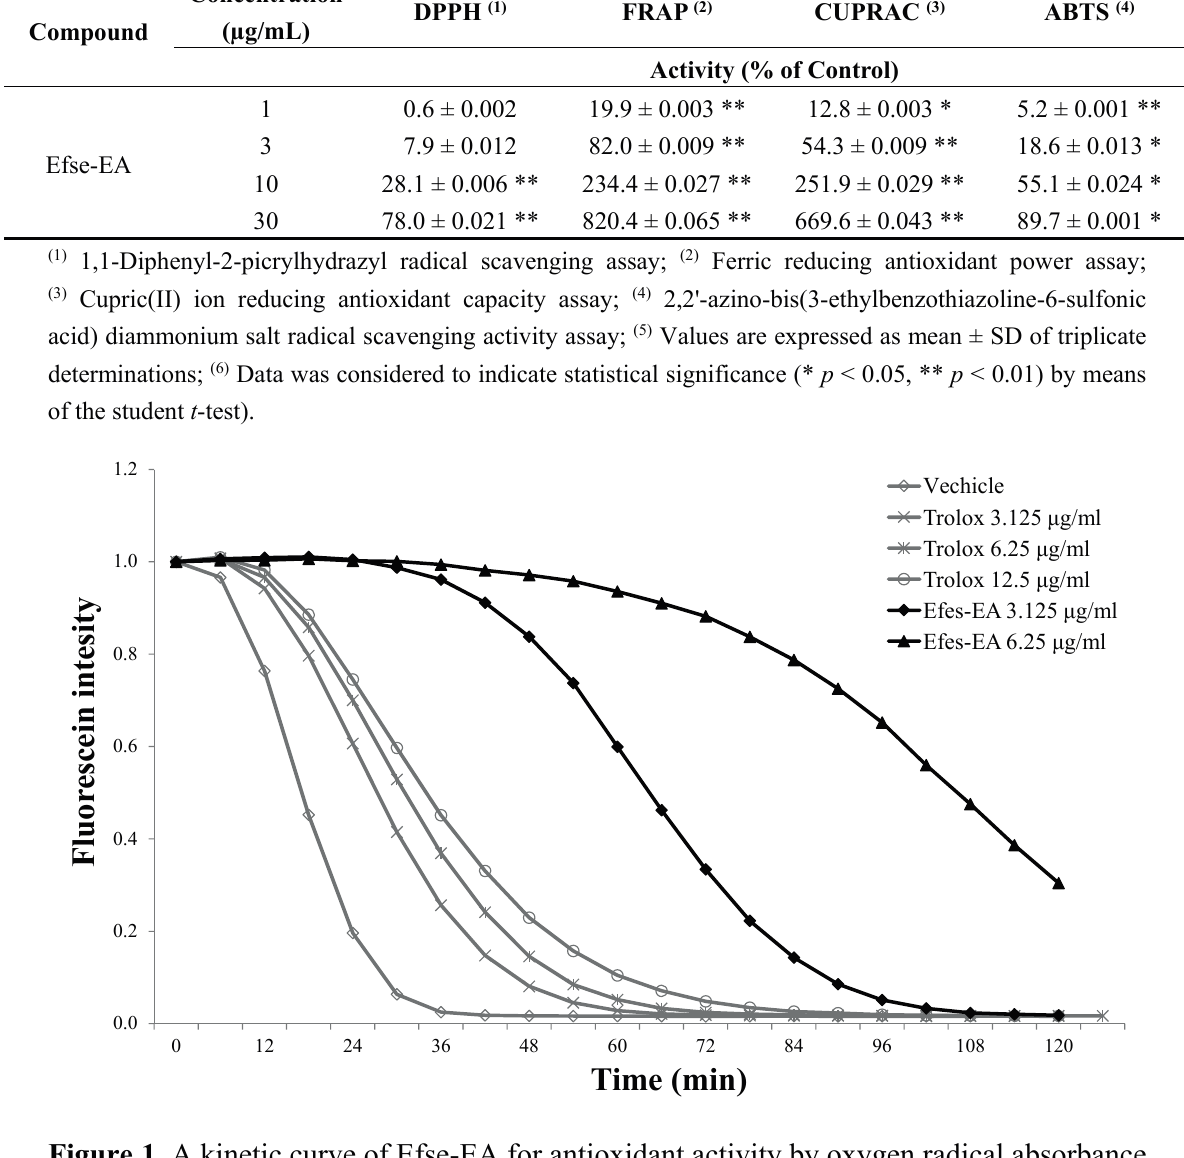
Figure 1. A kinetic curve of Efse-EA for antioxidant activity by oxygen radical absorbance capacity (ORAC) assay. The ORAC assay was carried out as described in Experimental Section. The final ORAC values were calculated using the regression equation for the Trolox concentration plotted against the net area under the fluorescence decay curve (AUC; area under the curve). Open triangle, vehicle; open diamond, Trolox 3.125 µg/mL; open circle, Trolox 6.25 µg/mL; closed circle, Trolox 12.5 µg/mL; closed